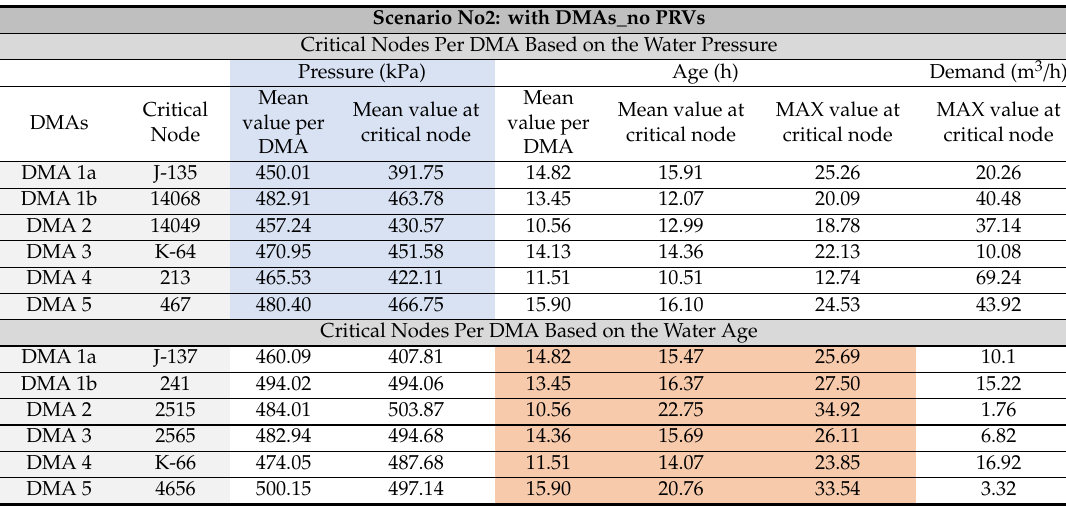
Table 2. Scenario No2 (withDMAs_no PRVs): (a) Critical nodes per DMA based on the water pressure. Respective water age and water demand values; (b) Critical nodes per DMA based on the water age. Respective water pressure and demand